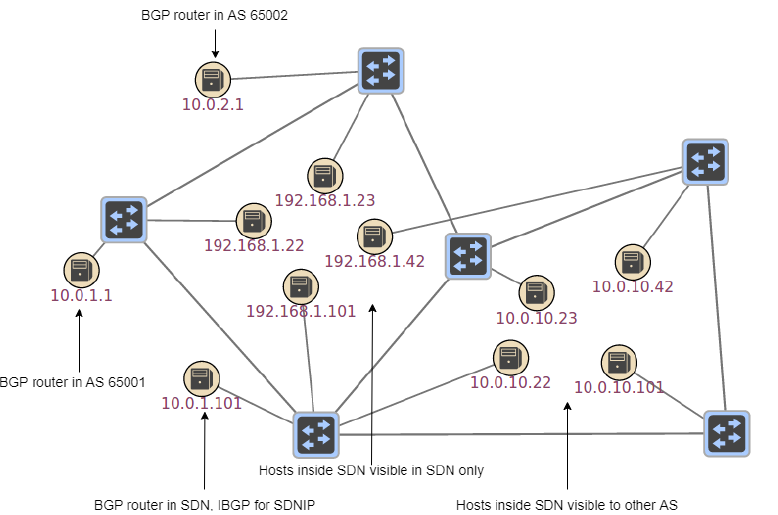
Figure 2. Experimental topology of SDN integrated with legacy networks. AS, Autonomous Sysgem, BGP, Boarder Gateway Protocol, SDN, Software-Defined